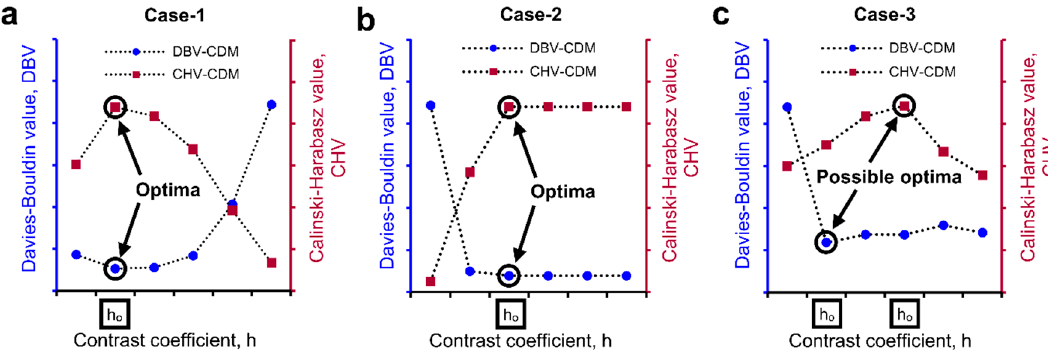
Figure 4. Cluster evaluation values and different cases of optimal h -value: ( a ) Case I- one optimal h -value; ( b ) Case II- optimal h -value over a range; and ( c ) Case III- two possible optimal h -values.